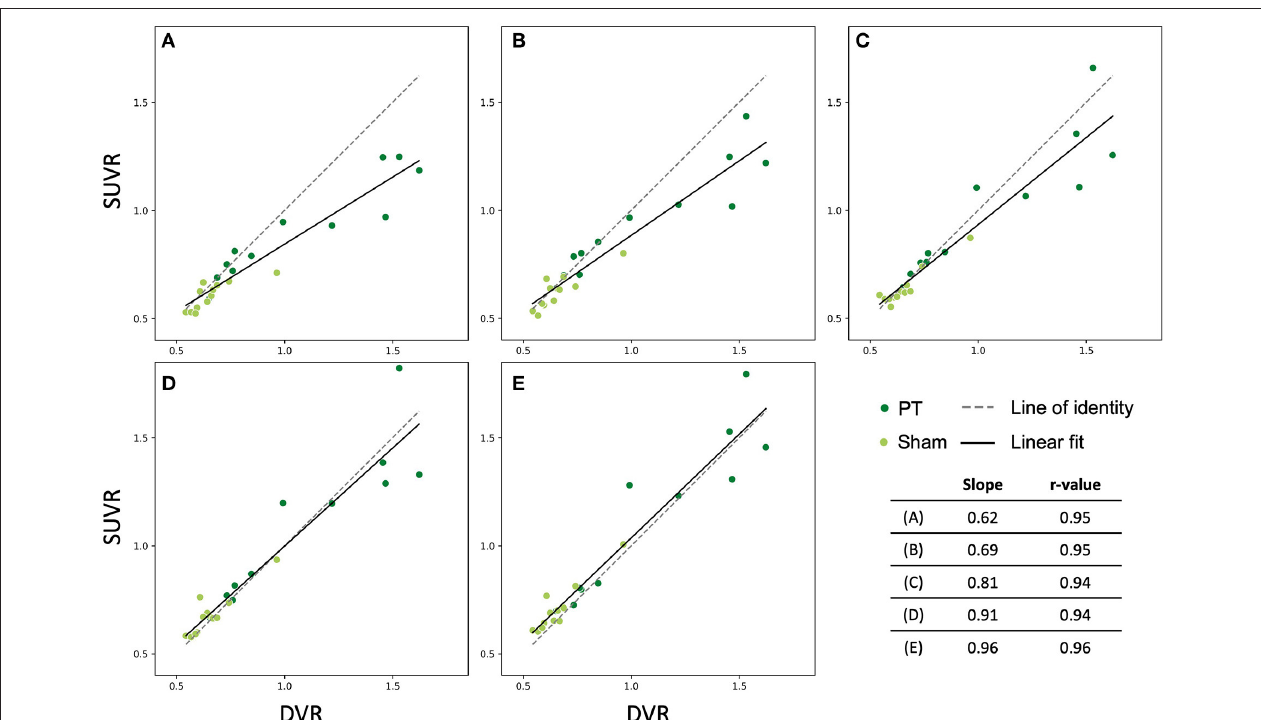
FIGURE 4 | Relationship between SUVR (late 10min frames) and DVR (0–90min) in the lesion VOI of the studied mice (all time points). Dark green dots indicate PT mice, light green dots represent sham mice. The solid and the dashed lines are the linear fit and the line of identity, respectively. (A) 40–50min frame, (B) 50–60min